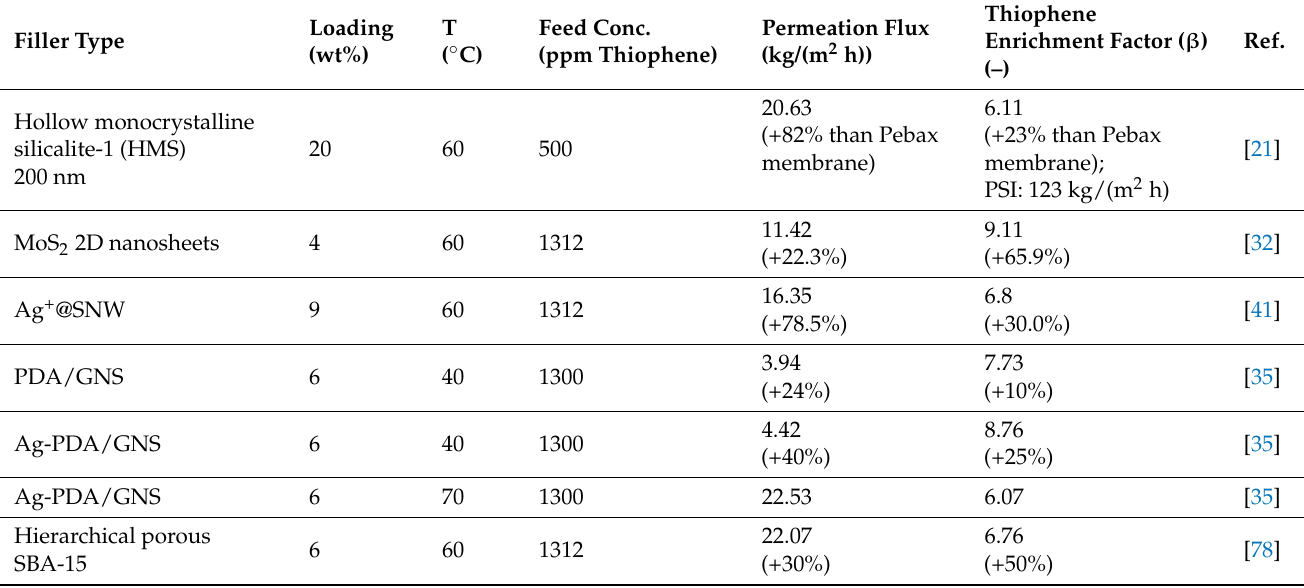
Table 7. Pervaporation performance of Pebax-based MMMs for gasoline desulfurization (thiophene removal from n